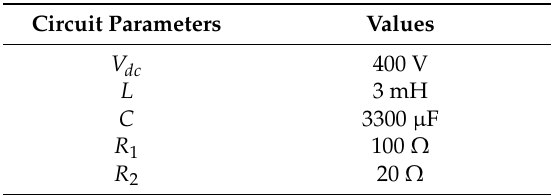
Figure 6. Control block for voltage control. Table 1. Circuit parameters for half-bridge type voltage balancer.